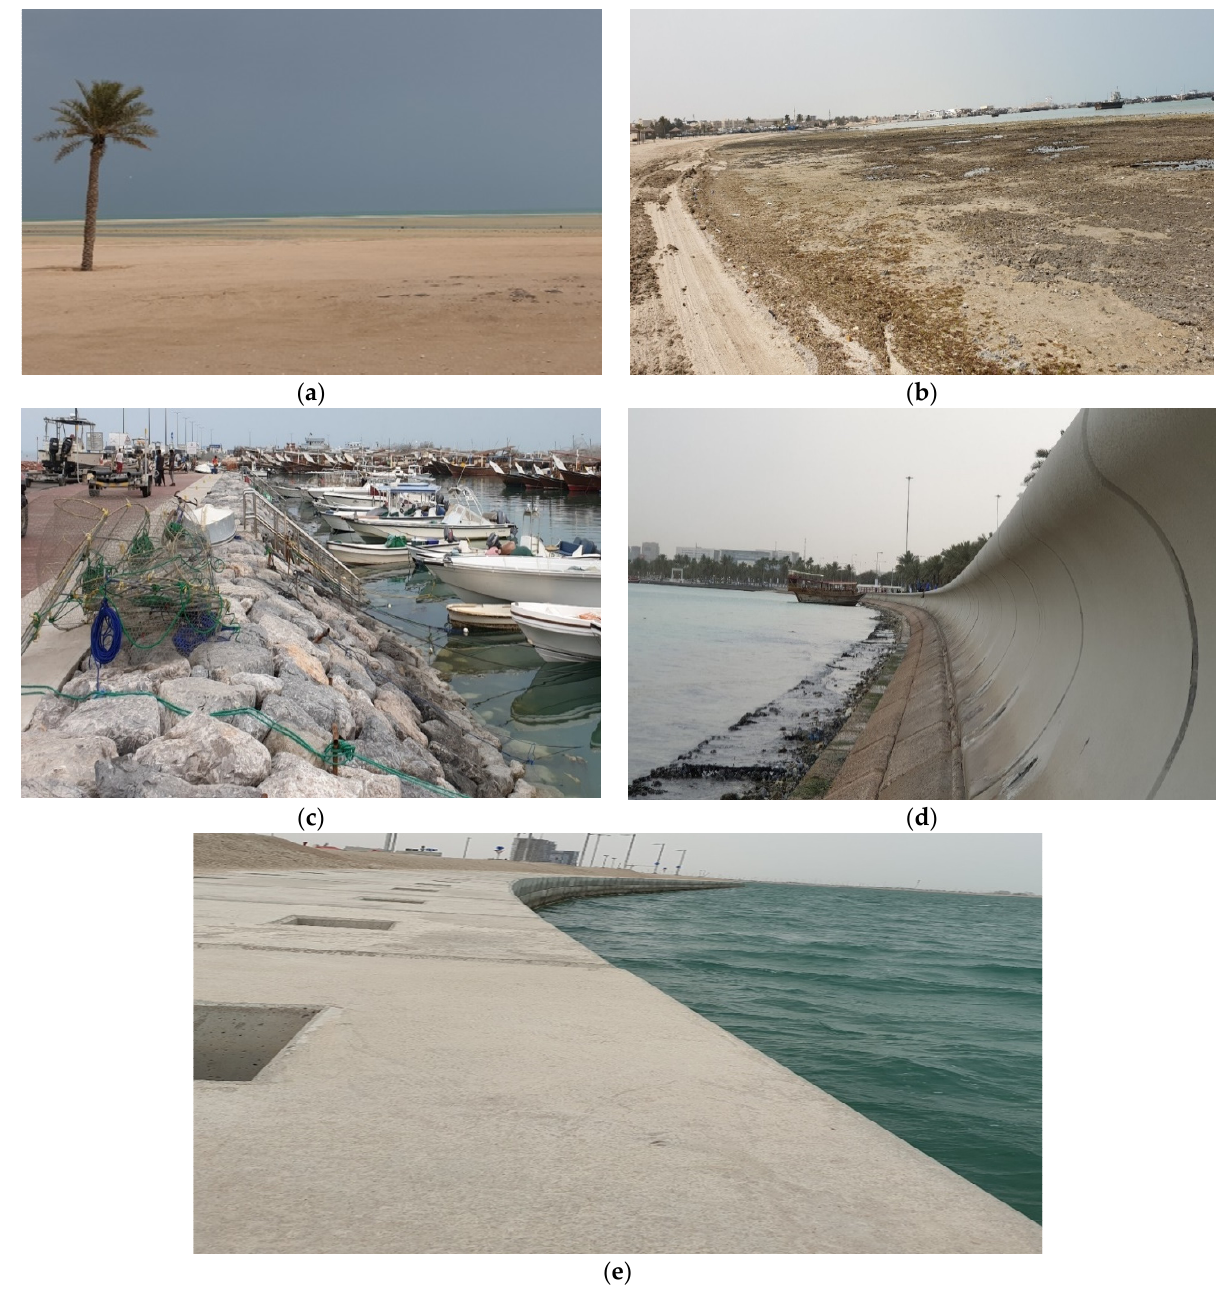
Figure 22. ( a ) Sandy beach in Al Wakra, ( b ) rocky beach in Al Wakra area, ( c ) shoreline protection structure built using natural limestone (Al Wakra Fishing Port), ( d ) protection structure built using concrete reinforcement (Al Corniche), ( e ) protection structure built using concrete reinforcement (Lusail City).